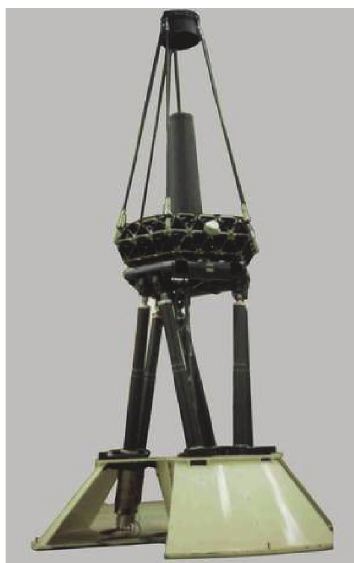
Figure 1: Telescope HPT Cerro Armazones, Chile.